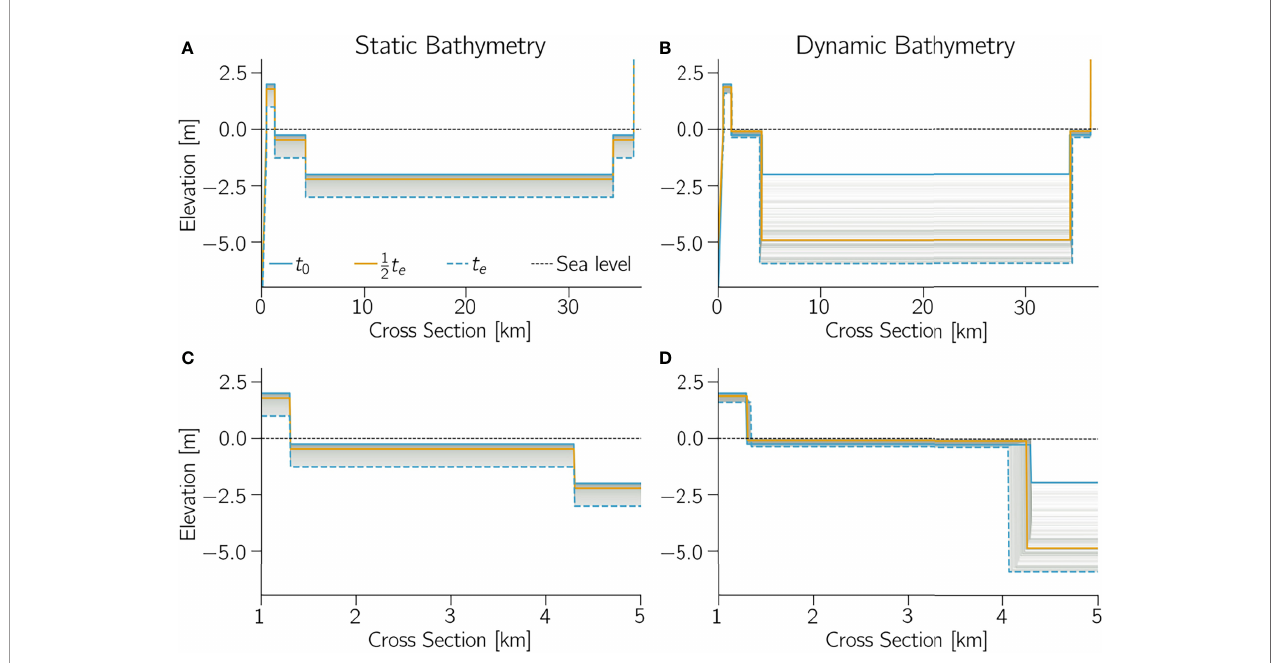
FIGURE 3 | Example realization of simulated bathymetry, where bathymetry is either static (A, C) or dynamic (B, D) ; open ocean is to left. Note that the ower panes (C, D) show close-ups of back-barrier marsh and t o is start of simulation (year 2000) while t e is end of simulation (year